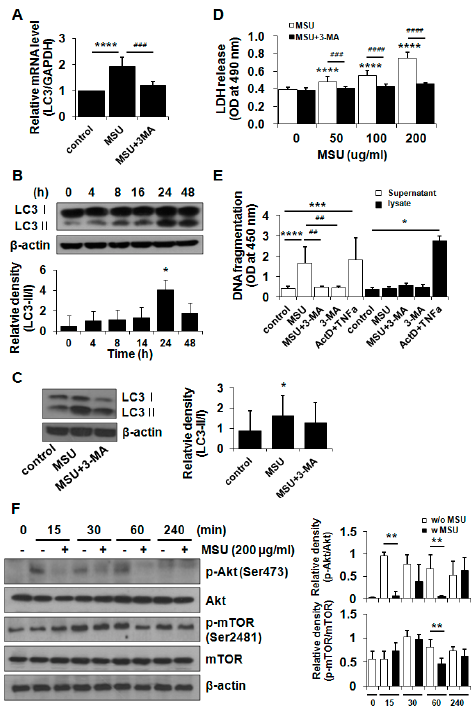
Figure 4. MSU crystal-induced chondrocyte death was mediated by the activation of the autophagy pathway. ( A ) The effect of MSU crystals on the mRNA expression of LC3. Chondrocytes were exposed to 3-MA (2 mM) for 3 h followed by treatment with MSU crystals (200 µg/mL) for 24 h. The level of LC3 was measured using RT-qPCR. Data represent the mean ± SD for duplicate experiments from three different donors ( n = 3). **** p < 0.001 vs. untreated cells, ### p < 0.005 vs. MSU crystal-treated cells; ( B ) The effect of MSU crystals on the conversion of LC3-I or LC3-II, an autophagy marker. Chondrocytes were exposed to MSU crystals (200 µg/mL) for 4, 8, 16, 24, and 48 h. The level of LC3-I to LC3-II was measured using Western blot analysis. Data are representative of three independent experiments from three different donors ( n = 3). Relative LC3-II/LC3-I ratio in Western blot data. * p < 0.05 vs. untreated cells; ( C ) MSU crystal-induced autophagy was inhibited by 3-MA. Chondrocytes were exposed to 3-MA (2 mM) for 3 h followed by treatment with MSU crystals (200 µg/mL) for 24 h. The level of LC3-I to LC3-II was measured using Western blot analysis. Relative LC3-II/LC3-I ratio in Western blot data. * p < 0.05 vs. untreated control cells; ( D ) MSU crystal-induced cell death was suppressed by an autophagy inhibitor. Chondrocytes were exposed to 3-MA (2 mM) for 3 h and incubated with MSU crystals (50, 100, and 200 µg/mL) for 24 h. Cell viability was determined using an LDH release assay. Data represent the mean ± SD for duplicate experiments from three different donors ( n = 3). **** p < 0.001 vs. untreated cells. ### p < 0.005, #### p < 0.001 vs. MSU crystal-treated cells; ( E ) The effect of MSU crystals on DNA fragmentation in the presence of 3-MA. Chondrocytes were pretreated with 3-MA (2 mM) for 3 h and incubated with MSU crystals (200 µg/mL) for 24 h. The DNA fragmentation level was measured in the culture medium and cell lysates using a cellular DNA fragmentation ELISA kit. Act D- + TNF- α -treated cells were used as a positive control for DNA fragmentation, an apoptosis marker. Data represent the mean ± SD for duplicate experiments from three different donors ( n = 3). * p < 0.05, *** p < 0.05, **** p < 0.001 vs. untreated cells, ## p < 0.01 vs. MSU crystal-treated cells; ( F ) Akt/mTOR phosphorylation suppressed by MSU crystals in primary chondrocytes. Chondrocytes were treated with MSU crystals (200 µ g/mL) for 0, 15, 30, 60, and 240 min and harvested for Western blot analysis. The levels of Akt/p-Akt (Ser473) and mTOR/p-mTOR (Ser2481) were measured by Western blot analysis. β -actin was used as a loading control. The data are representative of three independent experiments from different donors ( n = 3). The relative phosphorylation levels of Akt and mTOR proteins. Protein density was normalized to the respective dephosphorylated protein. ** p < 0.01 vs. MSU-untreated cells. w/o MSU, without MSU crystals; w MSU, with MSU crystals.